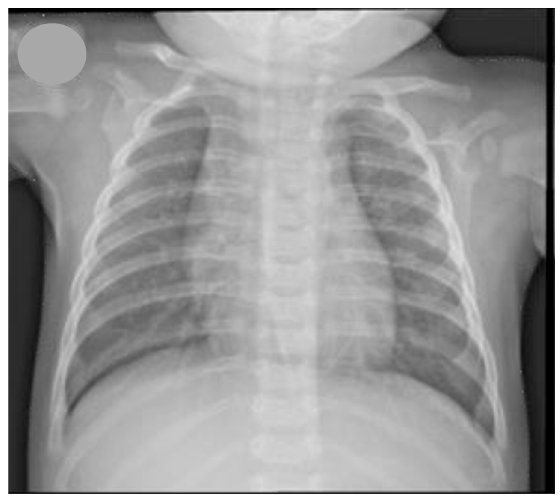
Figure 1. Chest X-ray showing a diffuse over-inflation of the lungs.